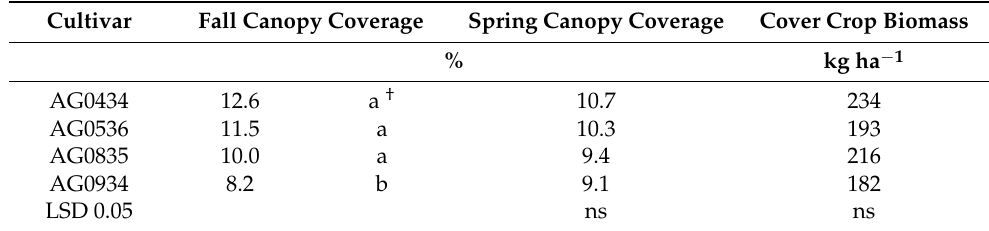
Table 6. Mean fall and spring canopy coverage and cover crop biomass for four soybean cultivars across four environments in Fargo, ND, USA, from 2016, 2017, and